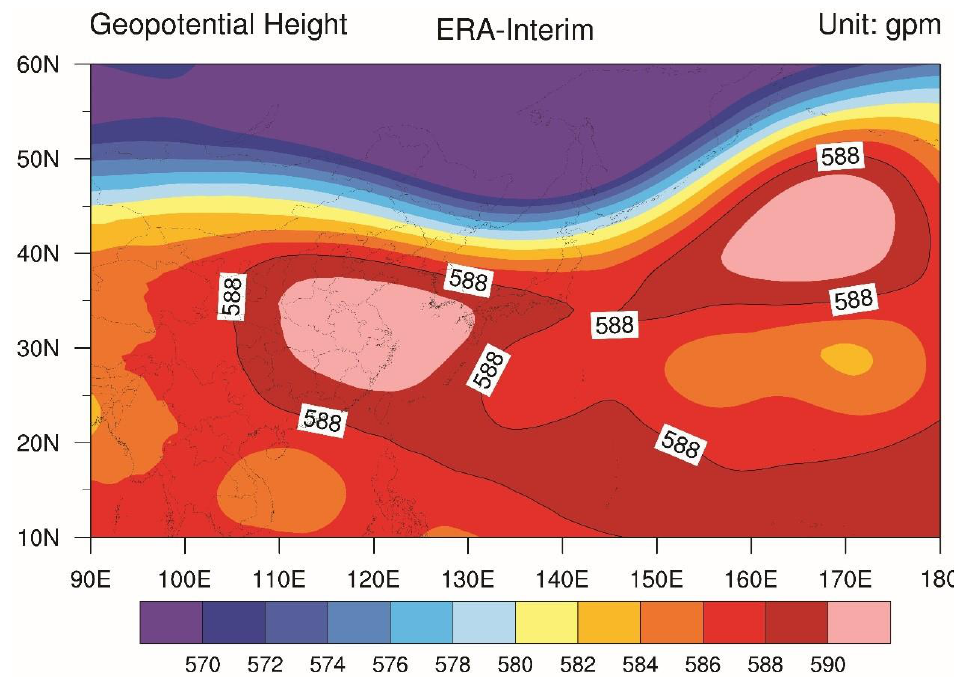
Figure 2. Synoptic weather pattern from ERA-Interim reanalysis data showing geopotential height (unit: gpm) at 500 hPa for the period from 21 to 25 July 2017 around East China.